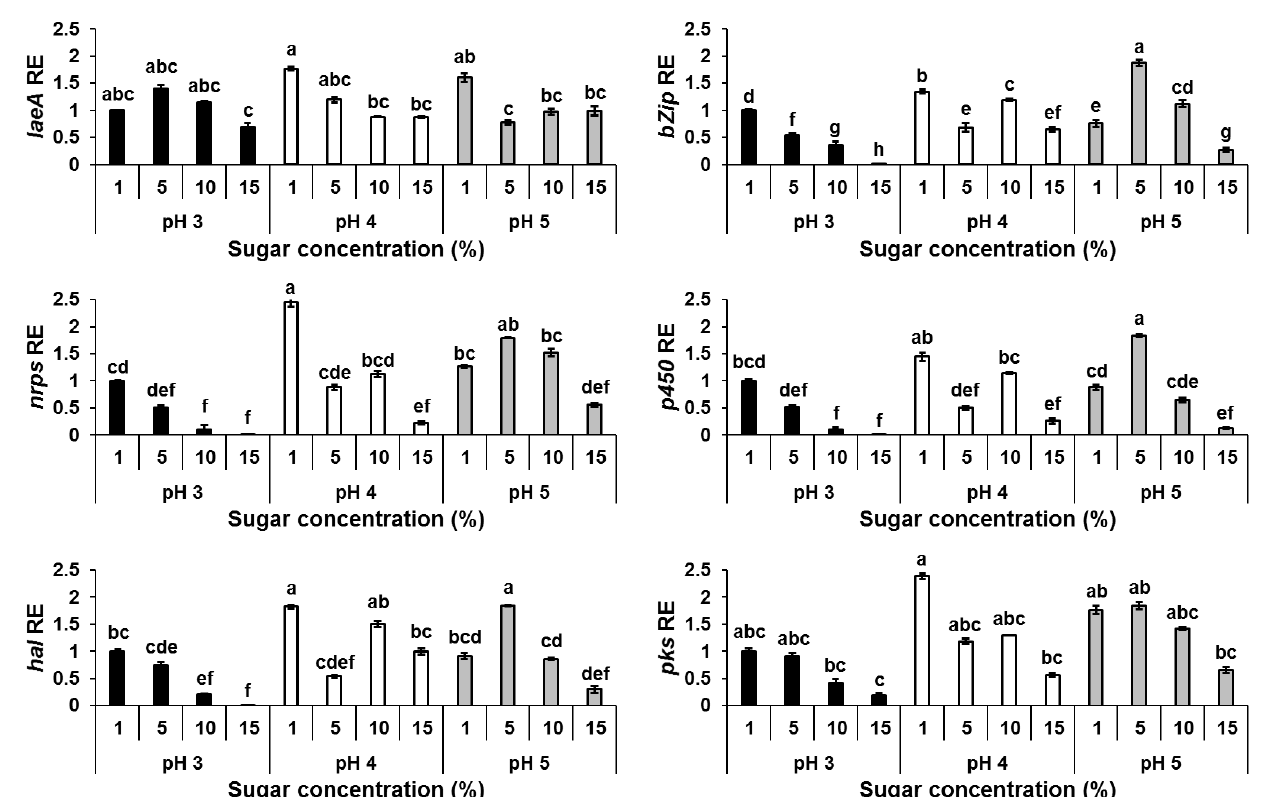
Figure 3. laeA and OTA gene cluster relative expression as affected by sugar concentrations and pH levels. Solid SGM media was amended with different sugar concentrations. The media was inoculated with 100 µ L of a 10 6 spore/mL suspension and the relative expression of laeA , bZIP , nrps , p450 , hal and pks genes were compared at different conditions. RNA was extracted from mycelia at day 6 post-inoculation. Relative expression was normalized using β -tubulin as an internal control. The expression of each gene under sugar concentration of 1% at pH 3 was normalized as 1.0. Error bars represent standard error of three independent biological replicates. Different letters above the columns indicate statistically significant differences at p < 0.05, as determined using the Tukey ’ s honest significant difference test.